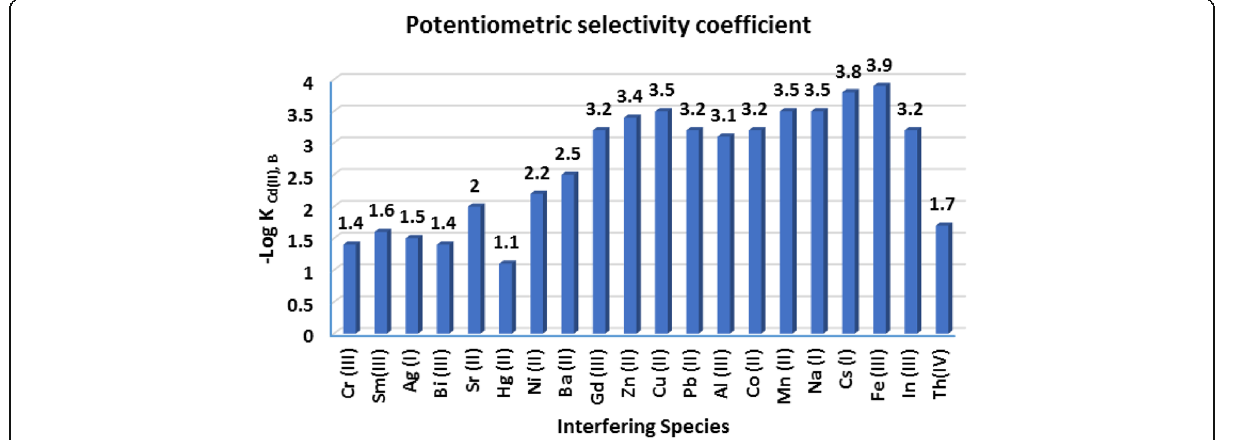
Fig. 7 Potentiometric selectivity coefficient values of Cd(II)-CPE